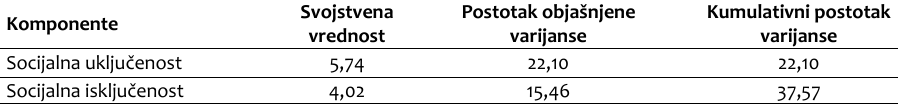
objašnjenju 37,57% ispitivane pojave. Primenjena skala procene za merenje stavova studenata o socijalnoj uključenosti i isključenosti ima prihvatljive merne karakteristike, što zaključujemo na osnovu kumulativnog procenta, kao i procenta objašnjene varijanse za svaki ekstrahovani faktor pojedinačno. Tabela 1 . Faktorski model socijalne uključenosti i socijalne isključenosti